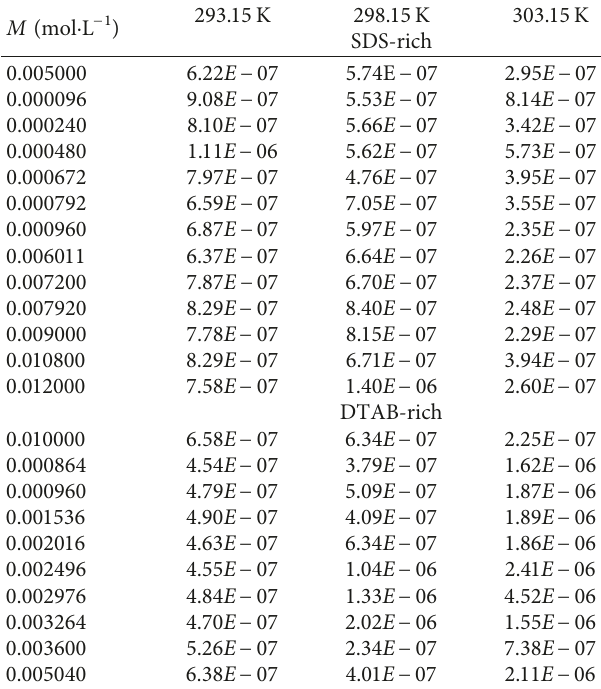
Table 3: Viscous relaxation time ( τ /ps) of SDS-rich and DTAB-rich surfactants in the aqueous medium at three different